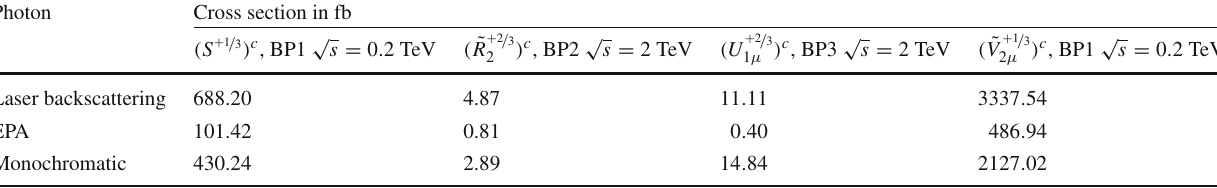
Table 14 Cross section for production of leptoquarks in the chosen four scenarios with laser backscattering, equivalent photon approximation and monochromatic photon at e – γ collider Photon